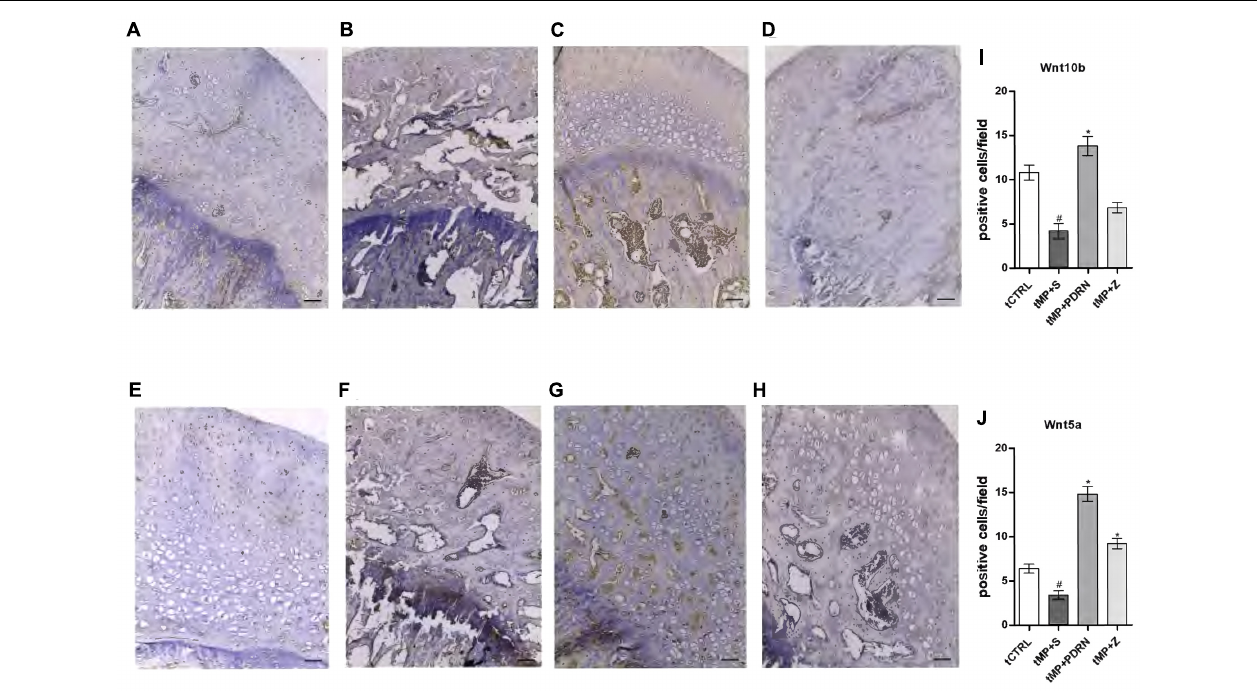
FIGURE 5 | Wnt immunostaining. (A–D) Representative Wnt10b immunostaining of femoral head sections, scale bar 20 µ m. Haematoxylin counterstain. (A) tCTRL, (B) tMP+S; (C) tMP+PDRN; (D) : tMP+Z. (E–H) Representative Wnt5a immunostaining of femoral head sections, scale bar 20 µ m. Haematoxylin counterstain. (E) tCTRL, (F) tMP+S; (G) tMP+PDRN; (H) : tMP+Z. (I,J) The graphs represent the number of positive cells for Wnt10b (I) and Wnt5a (J) , per high power field. ∗ p < 0.05 vs. tMP+S; # p < 0.05 vs. tCTRL. Data are expressed as means and